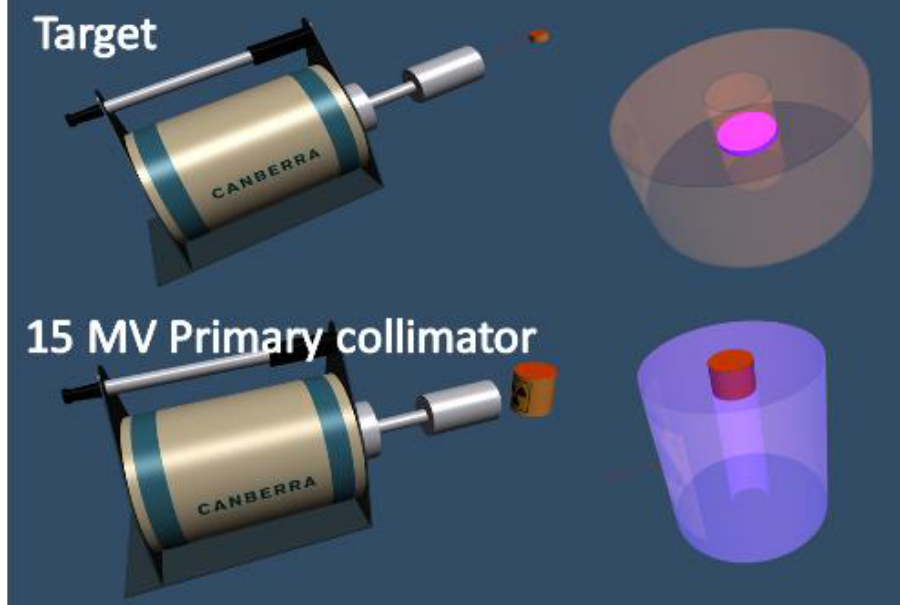
Figure 5. Two examples of the linac component simulation with ISOCS TM software.